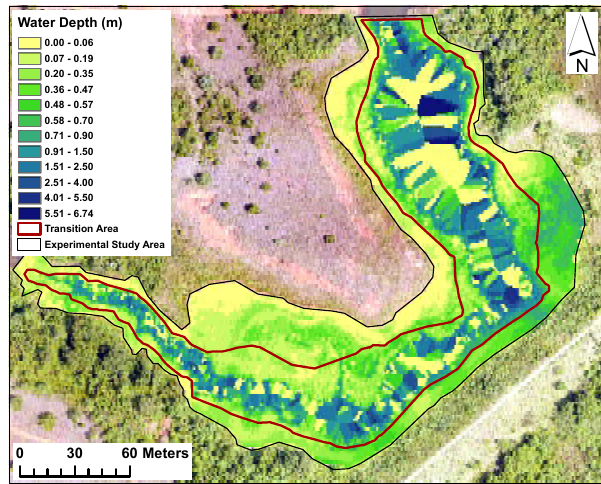
Figure 9. Bathymetry of Finn Creek 21 Reservoir using hlsmall UAS-SfM technique with a refraction index correction. The maximum detectable depth by the SfM is delineated by the red polygon.